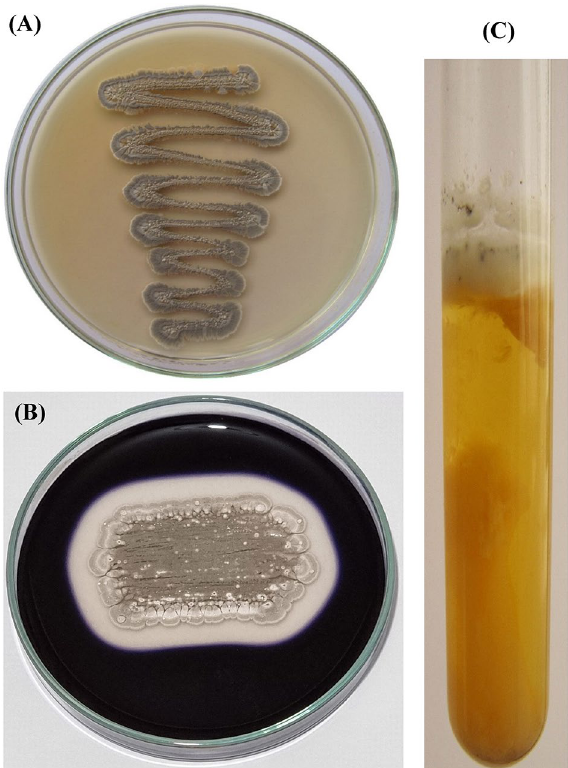
Figure 2. ( A ) Colored mycelium of Streptomyces sp. strain NEAE-83. grown on yeast extract-malt extract agar medium. ( B ) Clearance zone of hydrolyzed starch by extracellular Streptomyces sp. amylases of. ( C ) Milk coagulation and